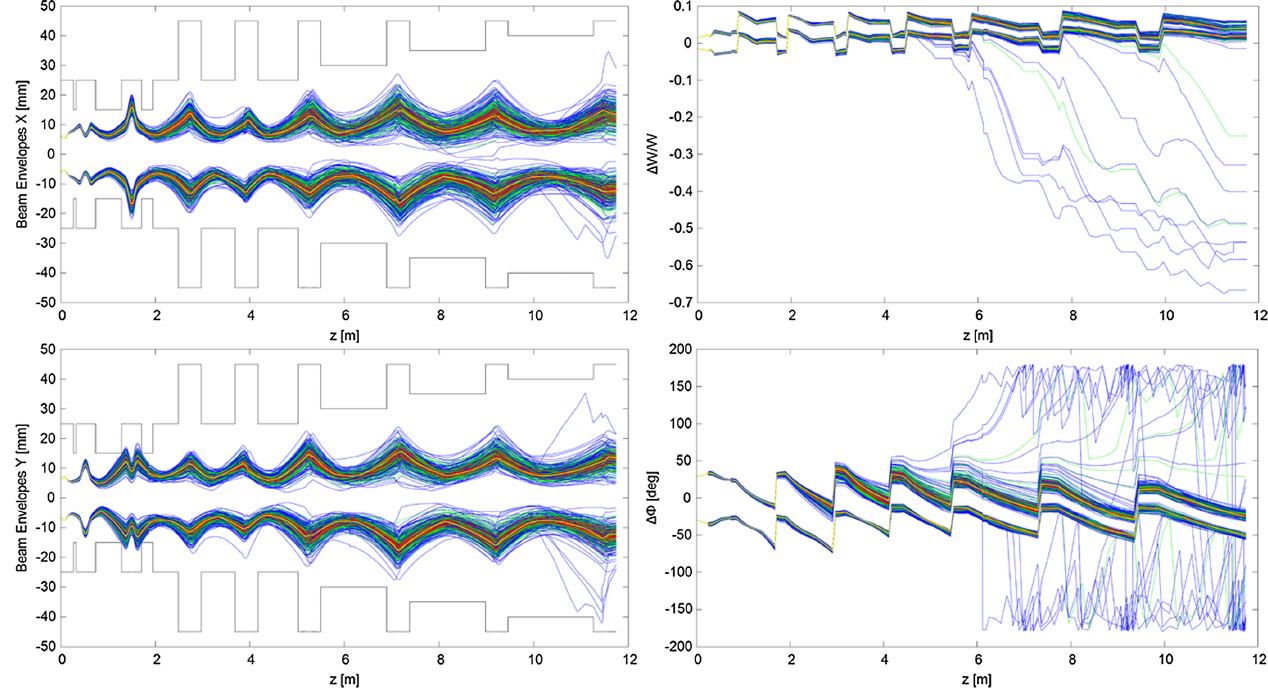
FIG. 14. Transverse (left graphs) and longitudinal (right graphs) 100% beam envelopes (all particles are included) from all runs with errors (red, batch 1; green, batch 2; blue, batch 3).